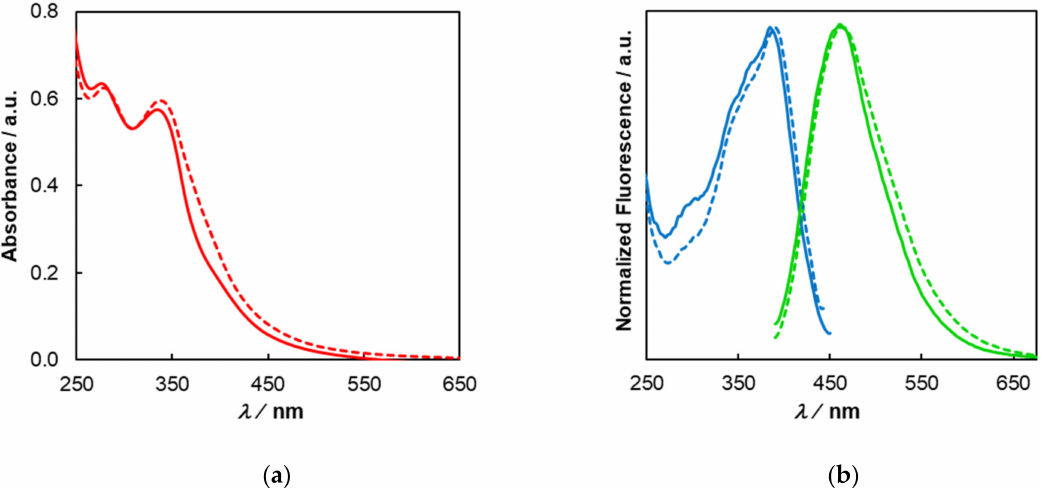
Figure 2. UV–Vis ( a ) and excitation (blue line; monitored at 461 nm) and emission (green line; λ exc = 380 nm) ( b ) spectra of aqueous dispersions (0.1 mg/mL) of C-dots from CGsSV (HTC (solid line) and Mw-HTC (dashed